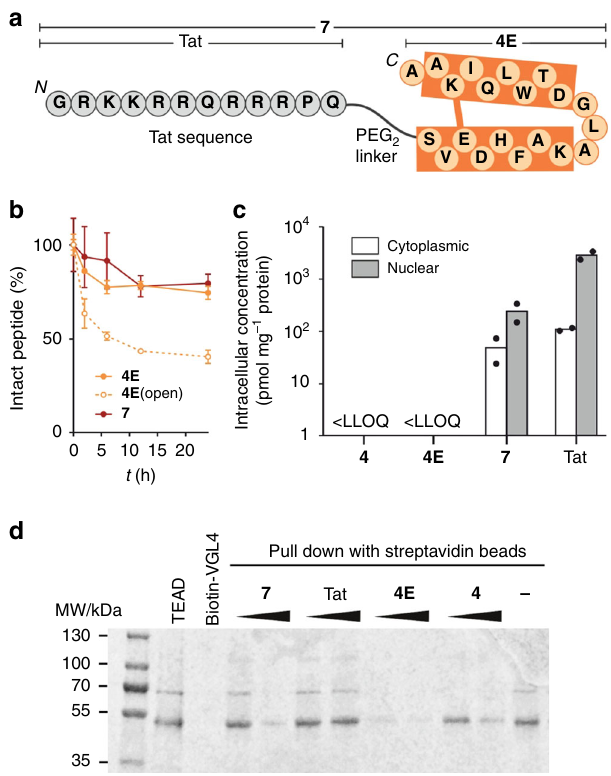
Fig. 3 Cell permeability, protease stability, and PPI inhibition of modi fi ed peptides were investigated. a Structure of peptide 7 consisting of peptide 4E (orange) N-terminally linked via PEG 2 (8-amino-3,6-dioxaoctanoyl) to the cell permeable peptide Tat (grey). b Time-dependent proteolytic stability of the peptides in cell culture media buffer containing 10% foetal bovine serum ( c (peptide) = 30 µ M) ( n = 2 technically independent replicates, error bars = SD). c Intracellular concentration of unlabelled peptides investigated by mass spectrometry (90 min incubation at c (peptide) = 25 µ M). Peptides 4 and 4E have concentrations below the lower limit of quanti fi cation (LLOQ), therefore they were not detected ( n = 2 biologically independent replicates, error bars = SEM). d In vitro competition pull-down is performed with a complex of recombinant GST- hTEAD1 and two-helix motif peptides in presence of synthetic biotin-VGL4 immobilized on streptavidin magnetic beads; after incubation for 2.5 h, hTEAD1 pull-down is analysed by SDS-PAGE ( n = 1 replicate). Source